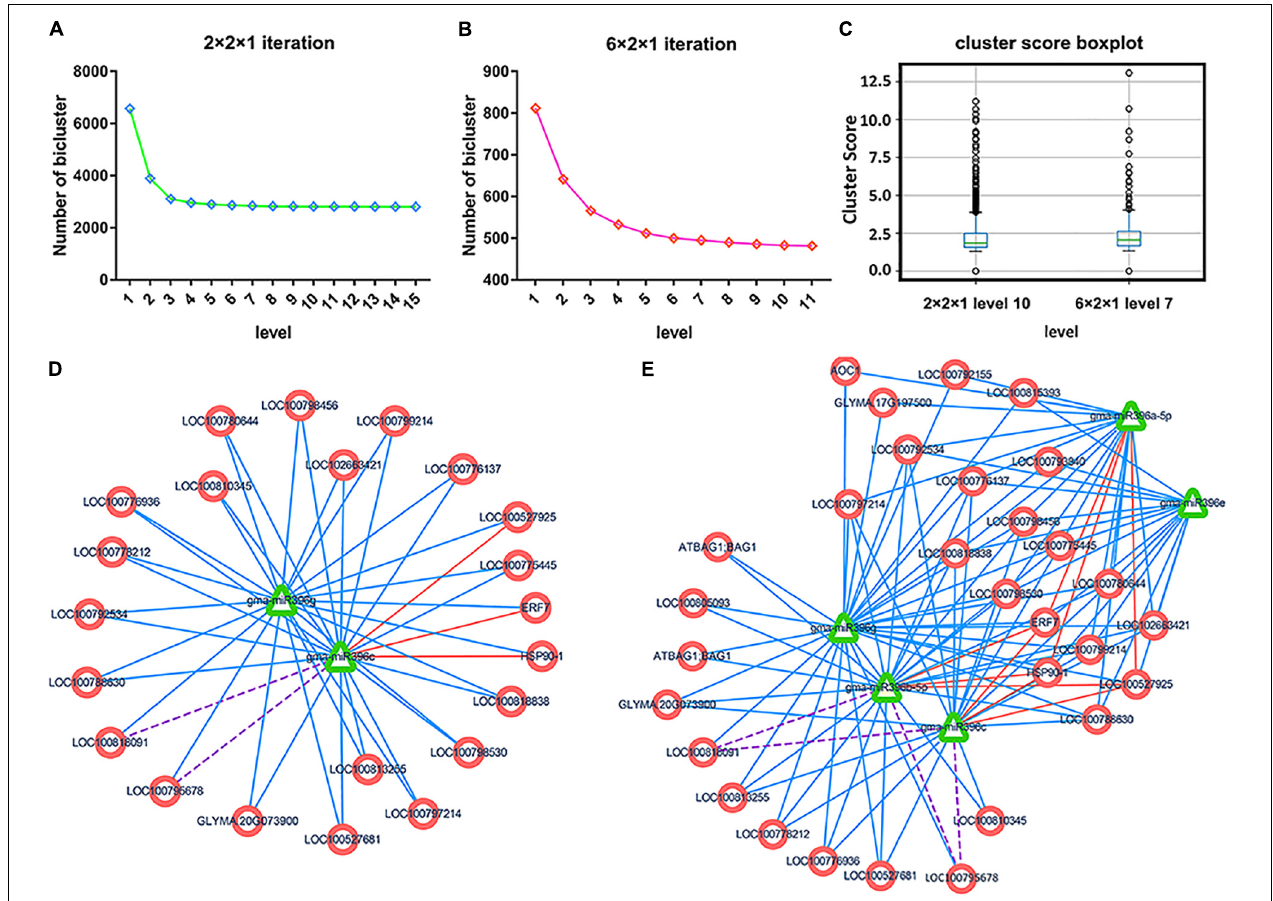
FIGURE 4 | Multi-level iterative biclustering results of soybean MTRMs. (A) Results under different iteration times at the 2 × 2 scale, (B) results under different iteration times at the 6 × 2 scale, and (C) the boxplot of the cluster score is calculated based on the gene ontology (GO) under the two scales when converging to a stable level, where based on the overall distribution, the results at the 6 × 2 scale are better; (D) shows the MTRM bicluster at level 1 before the 6 × 2 scale fusion, and (E) shows the corresponding MTRM bicluster at level 7 after the 6 × 2 scale